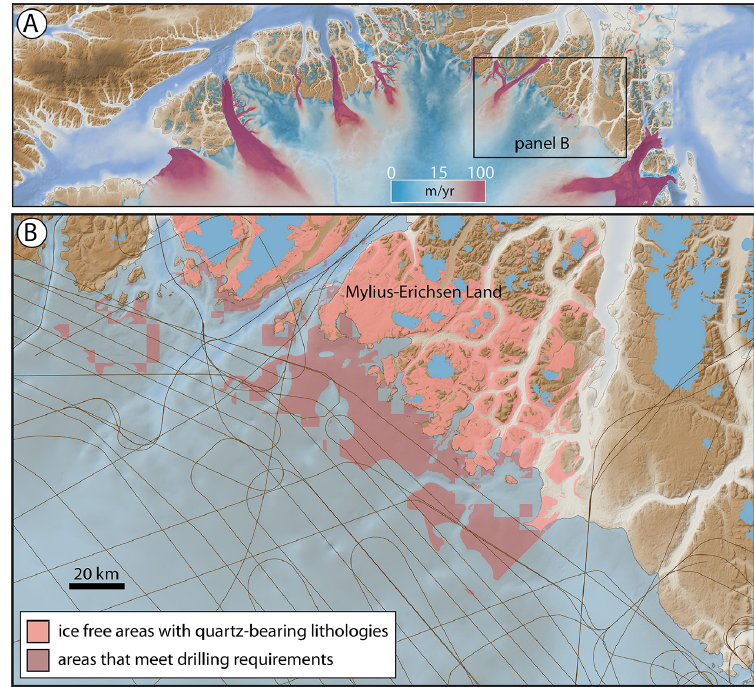
Figure 7. (a) North Greenland showing ice-sheet surface velocity; velocity from Greenland Ice Sheet velocity map from Sentinel-1, winter campaign 2019/2020 (version 1.3); QGreenland v2.0. (b) Mylius-Erichsen Land showing areas that meet drilling requirements, with pink areas representing quartz-bearing sedimentary formations (with mafic intrusives) beyond the ice margin. NASA Operation IceBridge (OIB) flight lines are shown as thin brown lines. Basemap topography and bathymetry from Morlighem et al. (2017).